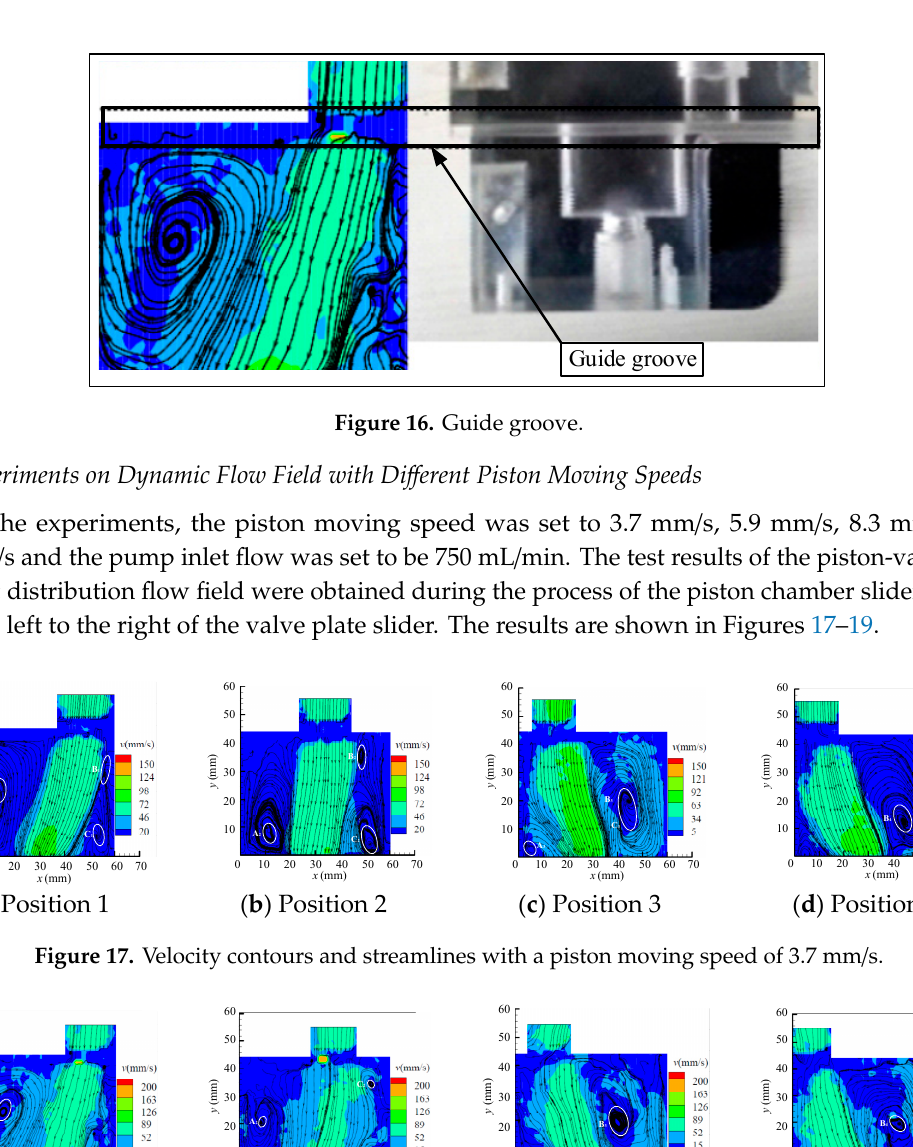
Figure 19. Velocity contours and streamlines with a piston moving speed of 12.5 mm/s.